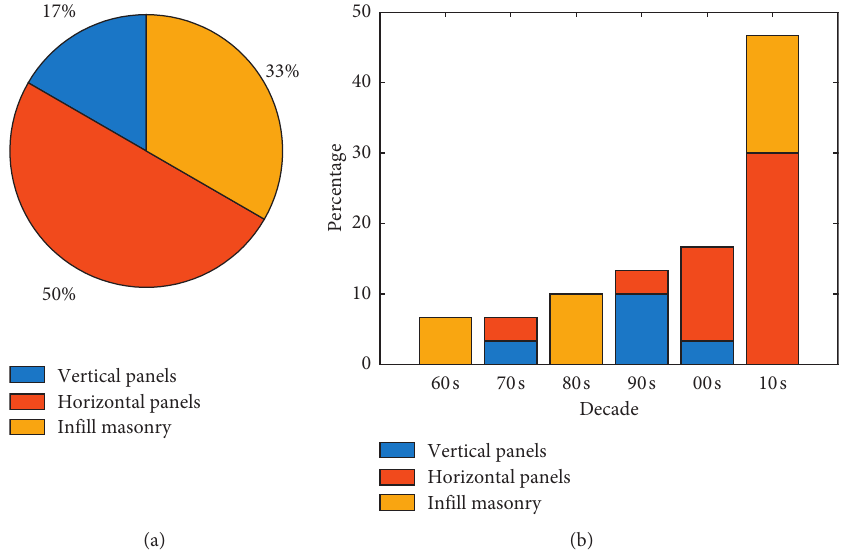
Figure 15: Variation of type of the cladding system by decade.